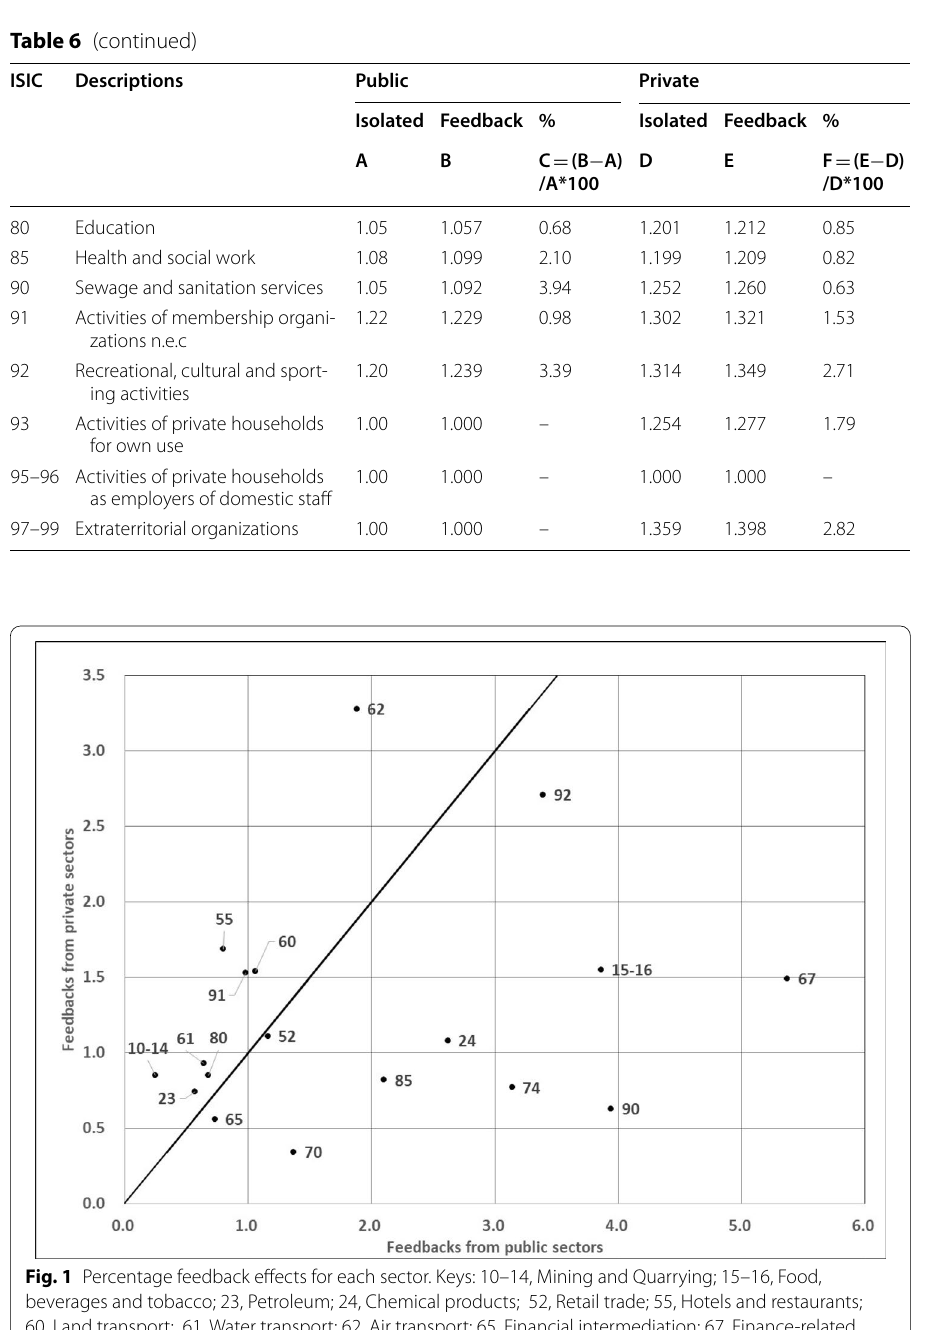
Figure 1 is plotted using percentage feedbacks for activities present in both public and private sectors under column C and column F, respectively, in Table 6. It shows visually the “location” of each sector in the private and public feedback space. The vertical axis